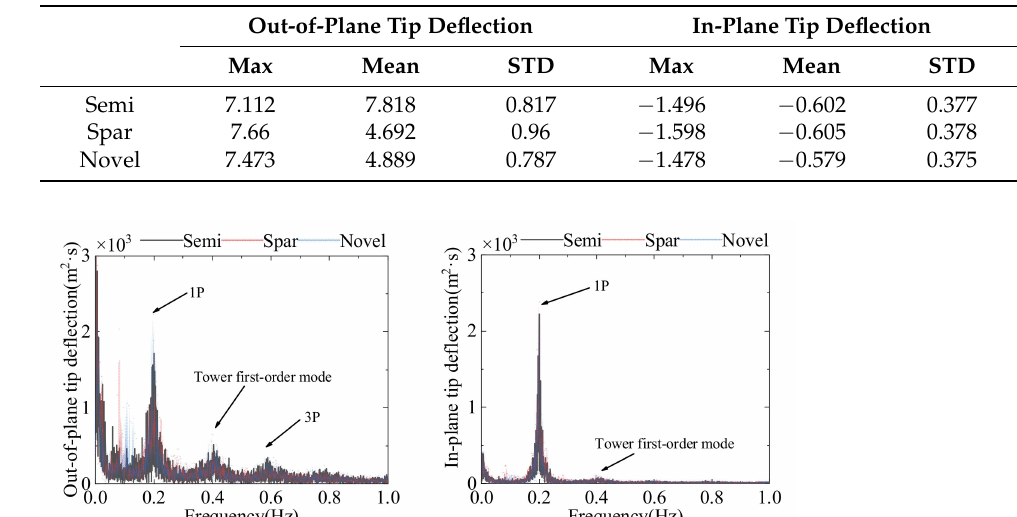
Table 9. Blade tip deflection statistics.